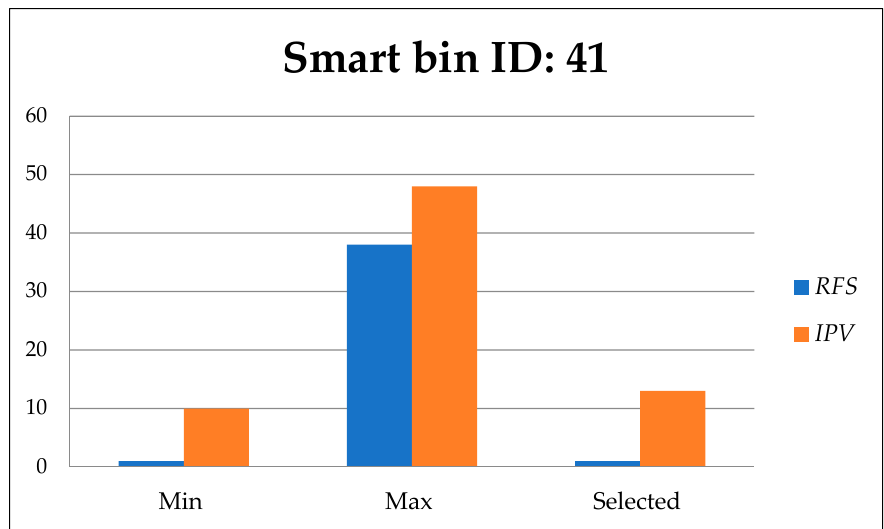
Figure 16. Residual free space R fs , and importance priority value IPv to smart bin id: 41.